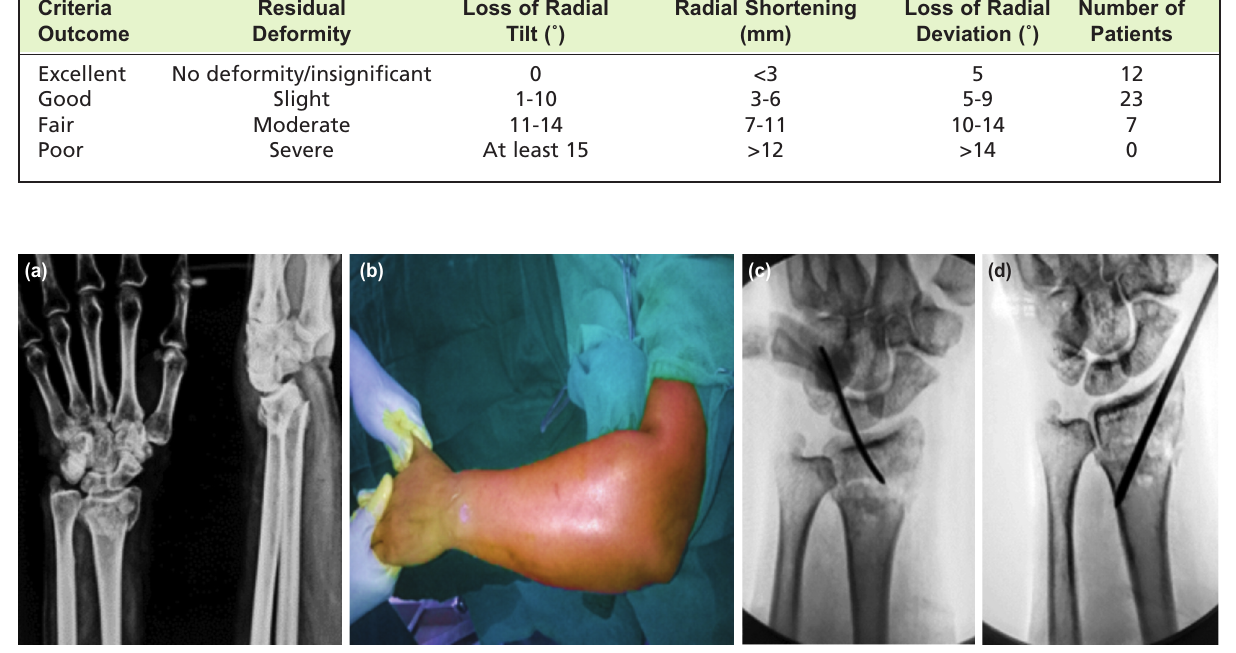
(a) Images showing unstable extra-articular distal radial fracture in both AP and lateral views, (b) closed reduction being Fig. 1: attempted with counter-traction, (c) intra-articular K-wire for maintaining the reduction, (d) additional temporary K-wire for stabilisation of the reduced fracture until final fixation.